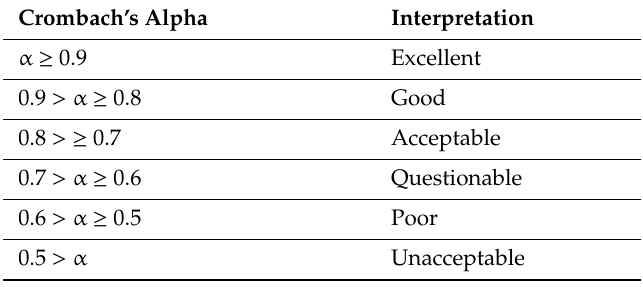
Table 1. Accepted rule of thumb for interpreting the Cronbach’s